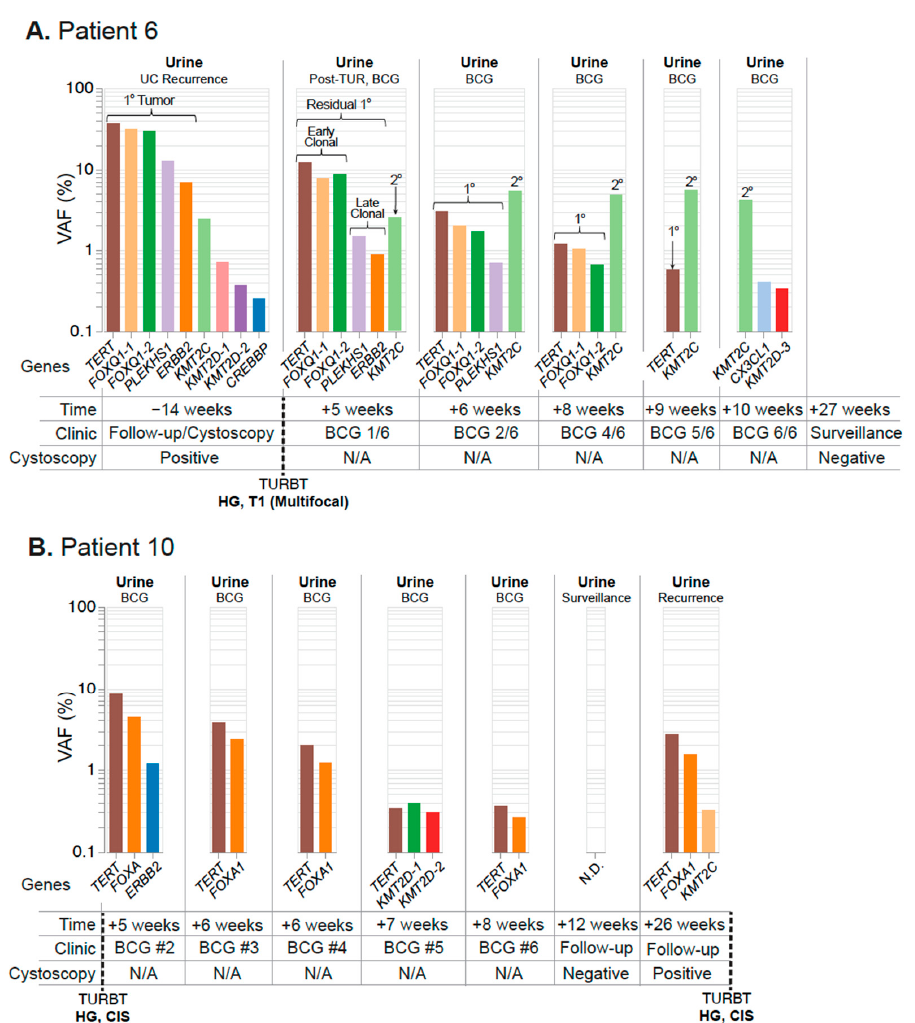
Figure 7. Residual disease surveillance during intravesical therapy. Longitudinal mutation pro-